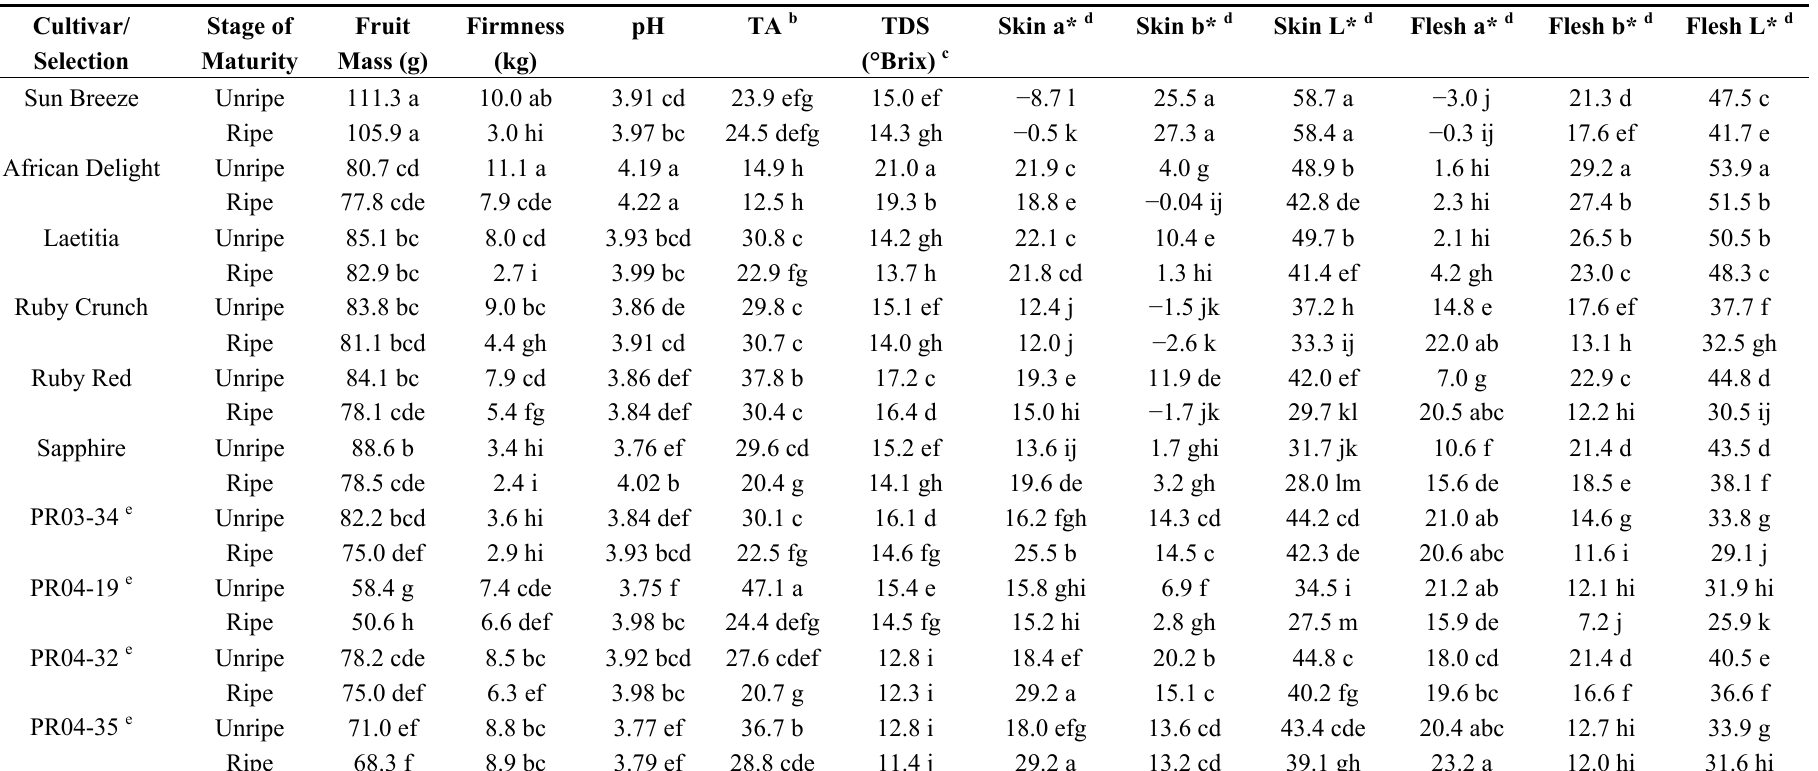
Table 3. Fruit attributes of unripe and ripe fruits from South African plum ( Prunus salicina Lindl.) cultivars and selections of the second harvest season a .